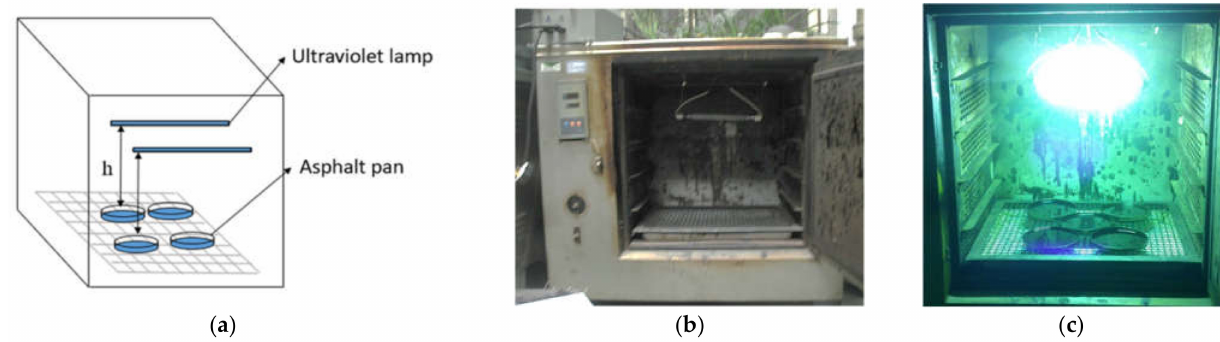
Figure 1. Ultraviolet aging oven: ( a ) design schematics, ( b ) actual equipment, ( c ) test photos.